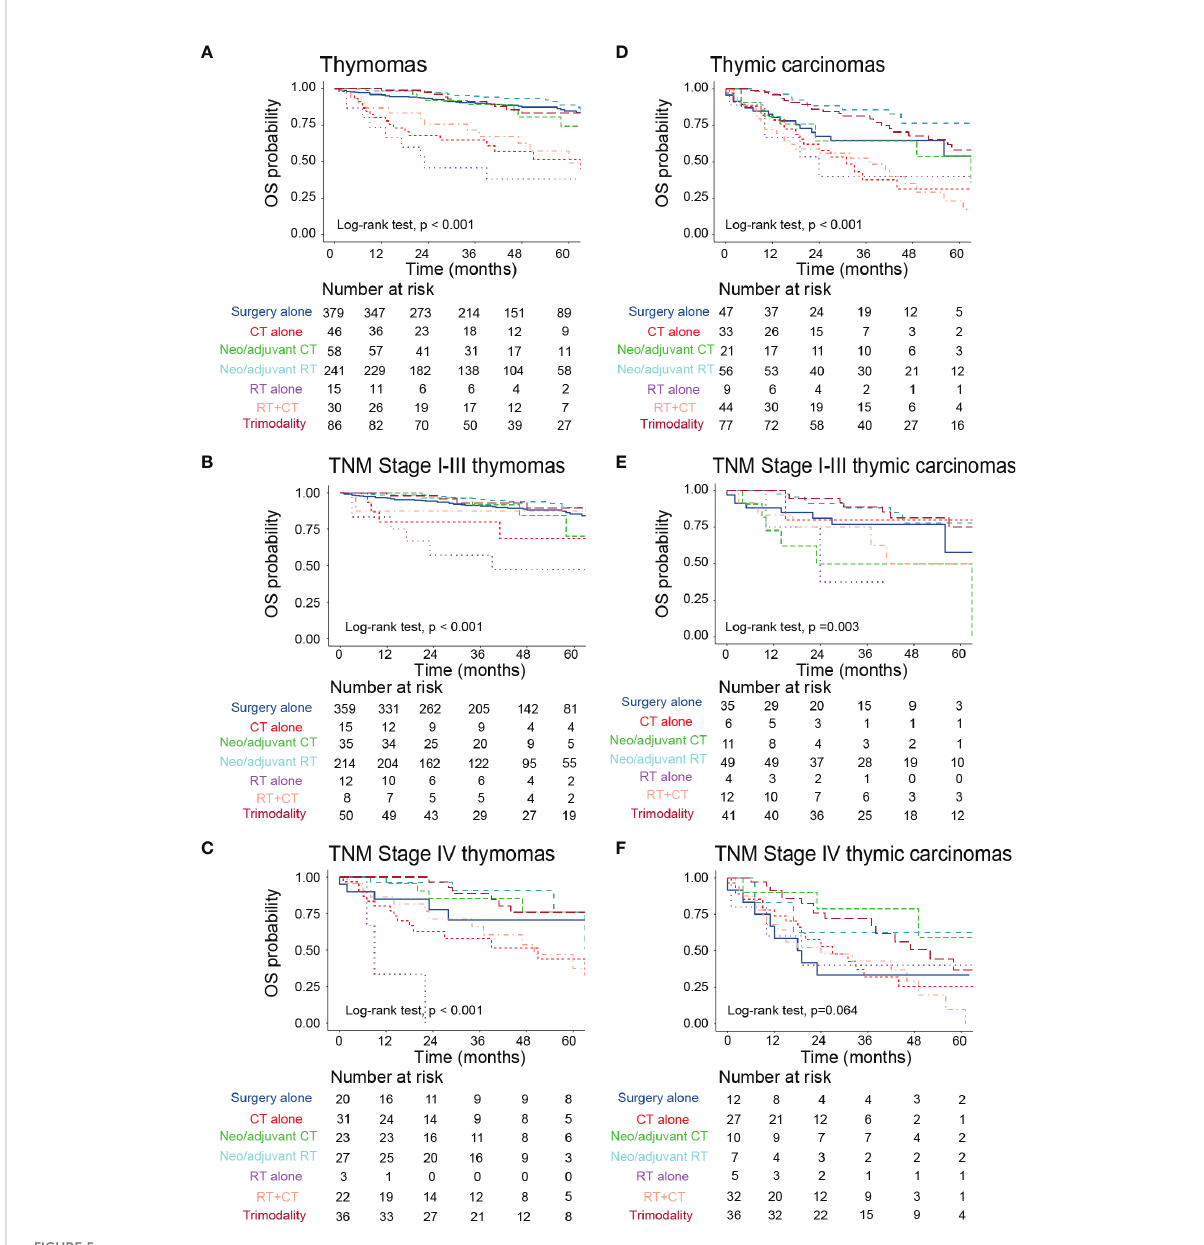
FIGURE 5 The impact of different treatment modalities on the prognosis of patients with TETs with different histologic subtypes. (A – C) Kaplan-Meier survival curves to display the survival difference among all stage thymomas (A) , TNM stage I-III thymomas (B) , and TNM stage IV thymomas (C) who received different treatments. (D – F) Kaplan-Meier survival curves to display the survival difference among all stage thymic carcinomas (D) , TNM stage I-III thymic carcinomas (E) , and TNM stage IV thymic carcinomas (F) who received different treatments. TETs, thymic epithelial tumors; RT, radiotherapy; CT, chemotherapy; OS, overall